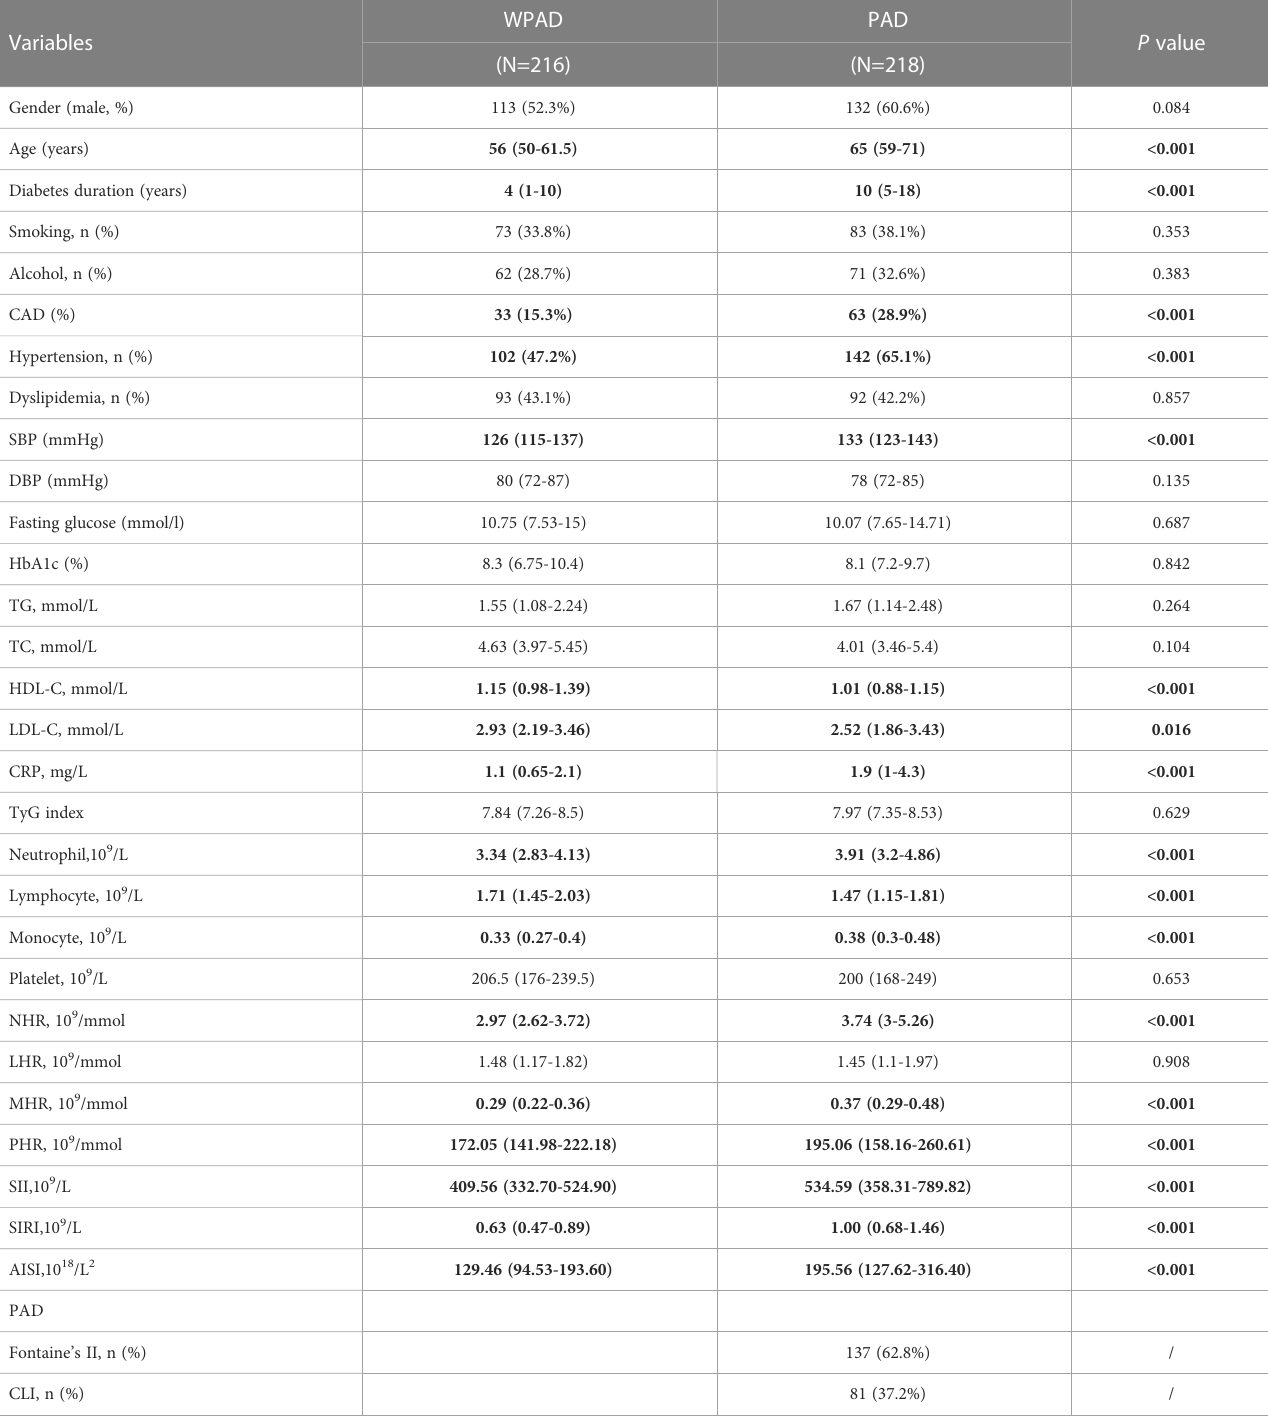
CAD, coronary artery disease; SBP, systolic blood pressure; DBP, diastolic blood pressure; HbA1c, glycosylated hemoglobin; TG, triglyceride; TC, total cholesterol; HDL-C, high-density lipoprotein cholesterol; LDL-C, low-density lipoprotein cholesterol; CRP, C-reactive protein; TyG index, triglyceride glucose index; NHR, neutrophil/HDL-C ratio; LHR, lymphocyte/HDL-C ratio; MHR, monocyte/HDL-C ratio; PHR, platelet/HDL-C ratio; SII, systemic immune-in fl ammation index; SIRI, system in fl ammation response index; AISI, aggregate index of systemic in fl ammation. P <0.05 (two-sided) was de fi ned as statistically signi fi cant. Bold values indicate statistically signi fi